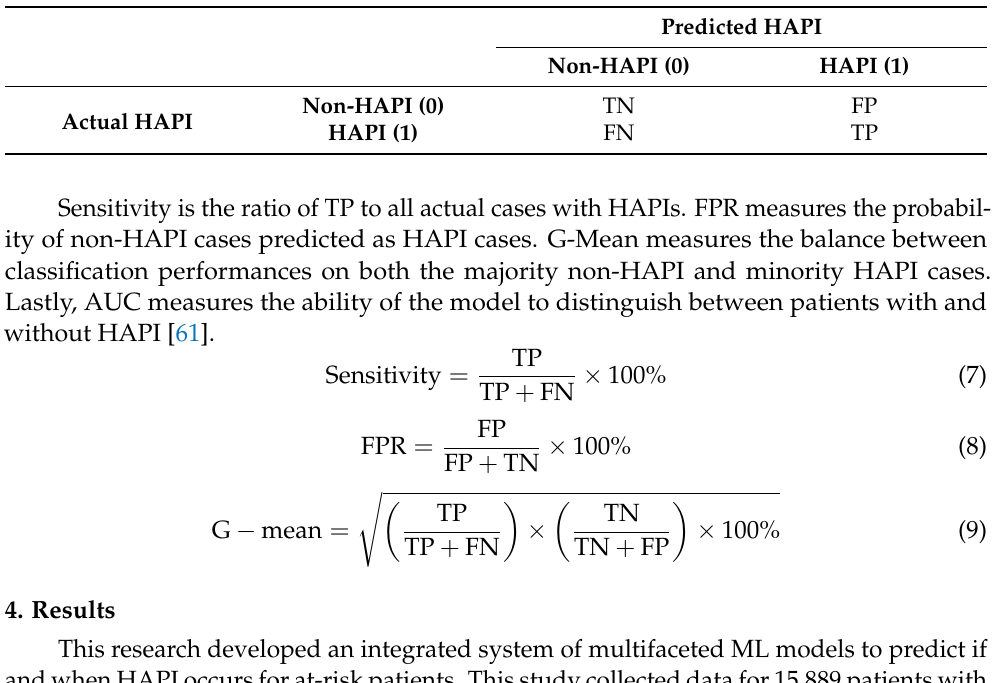
Table 2. Confusion